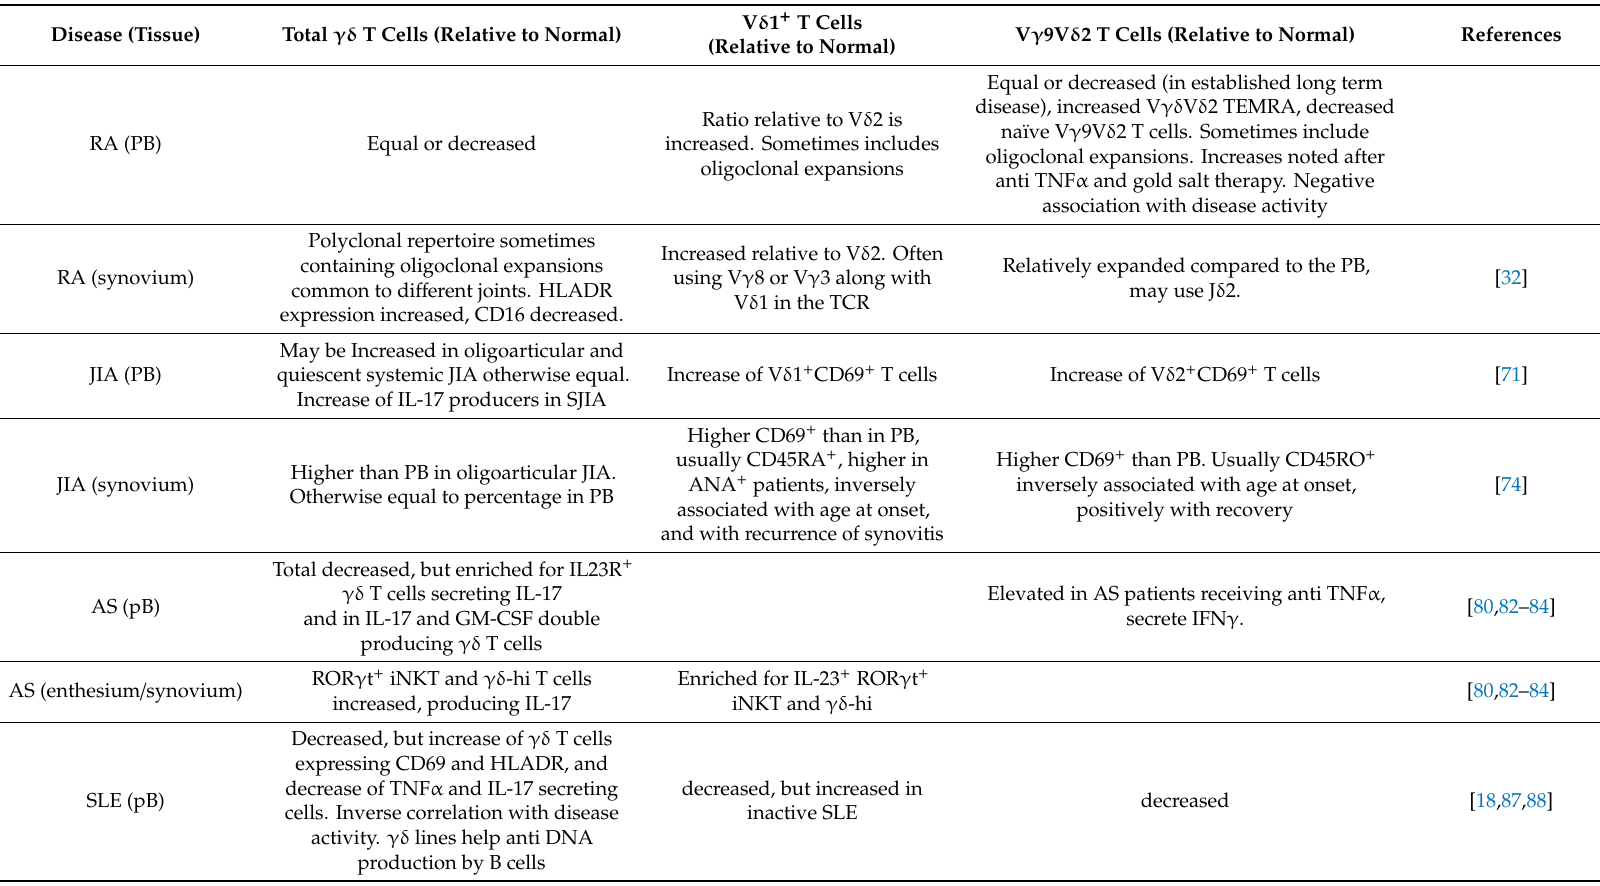
Table 1. Changes of γδ T cells in autoimmune rheumatic